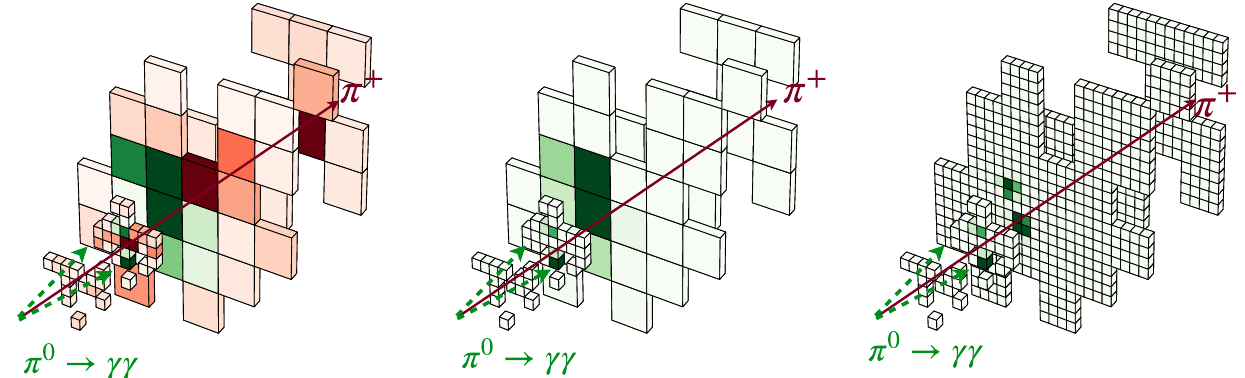
Fig. 2 A3-Ddisplaytheenergydepositsofa π + and π 0 → γγ ,inthe LG calorimeters (left), of the π 0 only (middle) and of the same π 0 only shower as captured by a HG calorimeter layer of 32 × 32 granularity